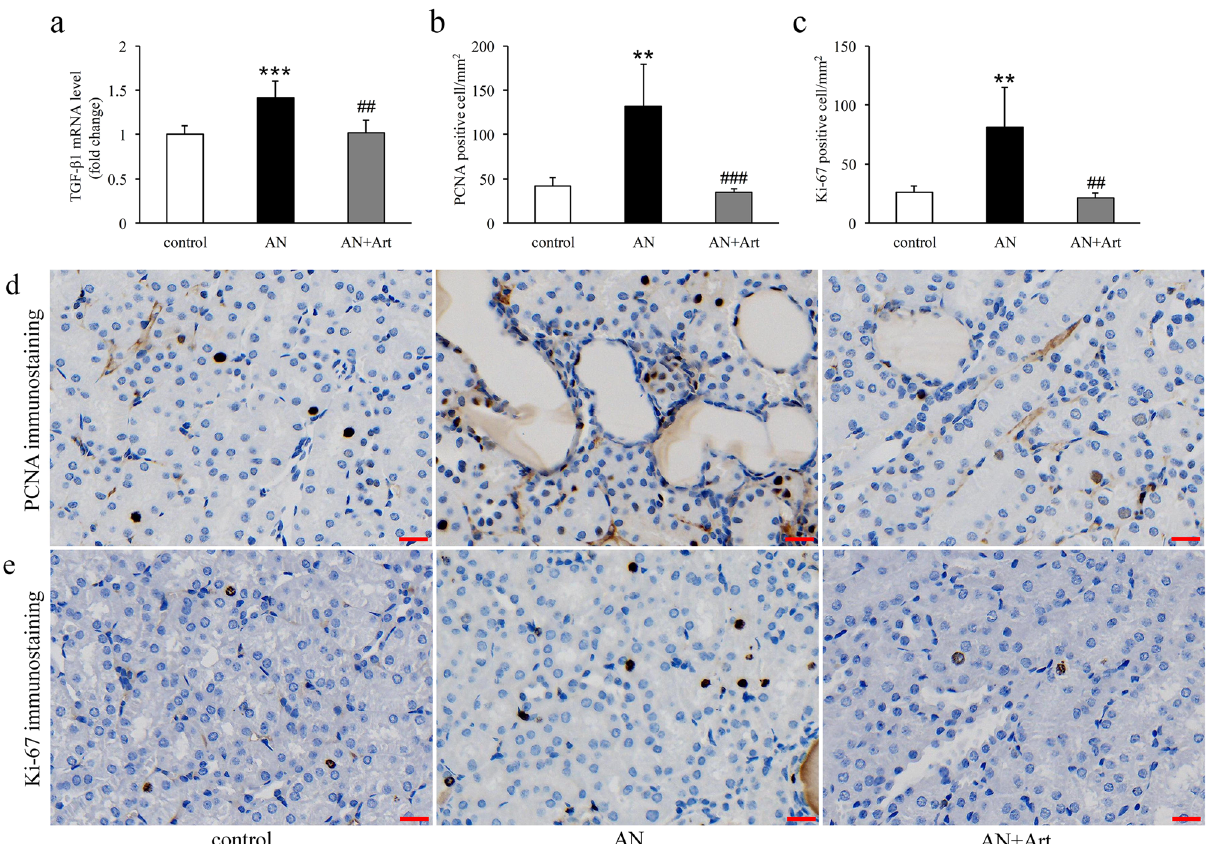
Figure 3. Artemether downregulated TGF-β1 mRNA expression levels and inhibited tubular proliferation. ( a ) Determination of renal TGF-β1 mRNA expression levels in each group. ( b , c ) Counting of PCNA and Ki-67 positive tubular cells per mm 2 in various groups. ( d , e ) Representative images of PCNA and Ki-67 immunostaining in each group. Scale bar, 20 μm. n = 6 per group. ** P < 0.01 and *** P < 0.001 versus control; ## P < 0.01 and ### P < 0.001 versus